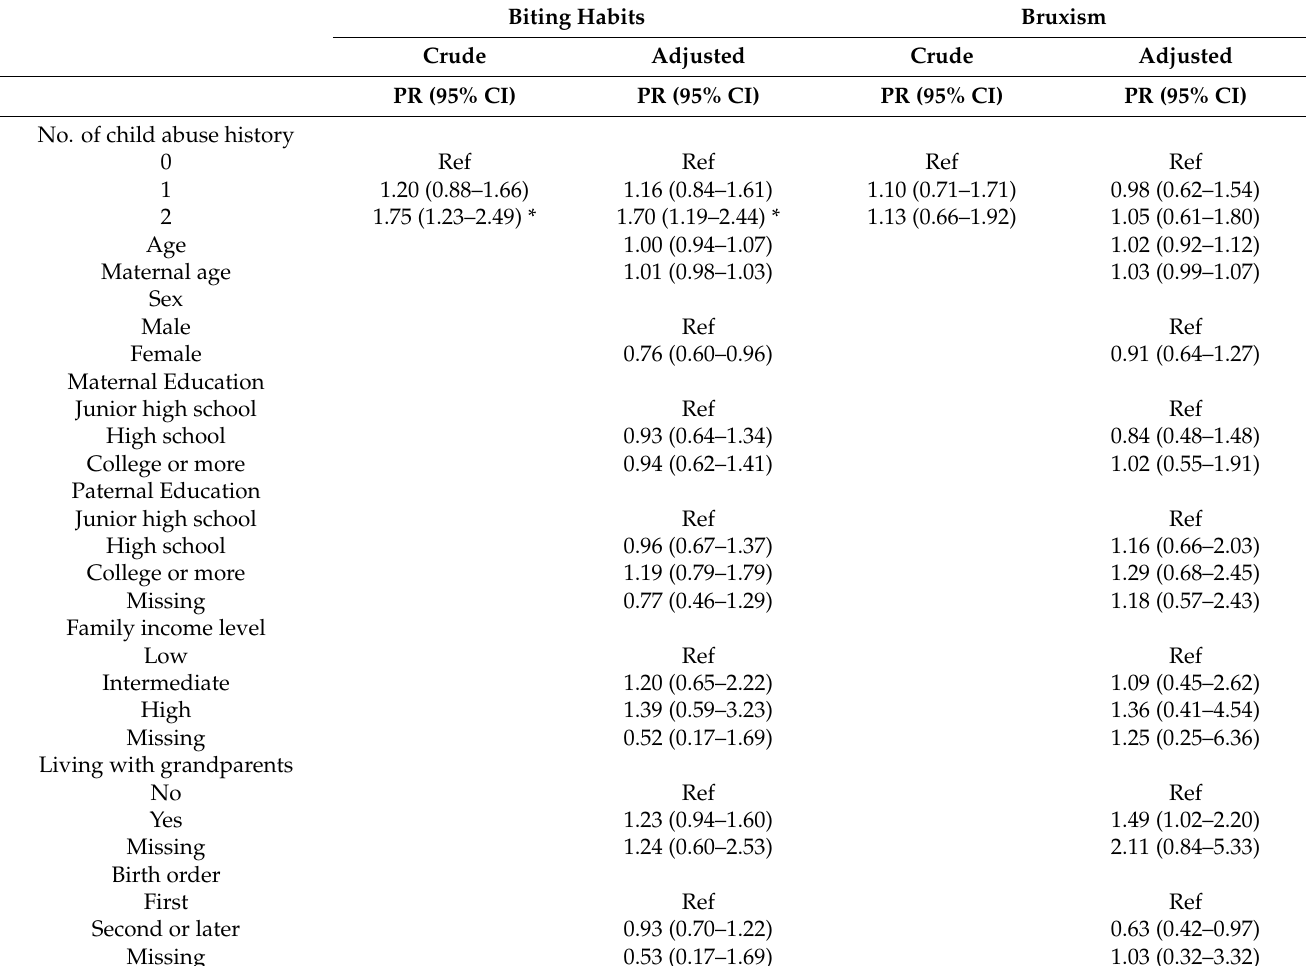
Table 4. Associations between the number of types of child abuse history and oral habits (N = 761 a ). Biting Habits